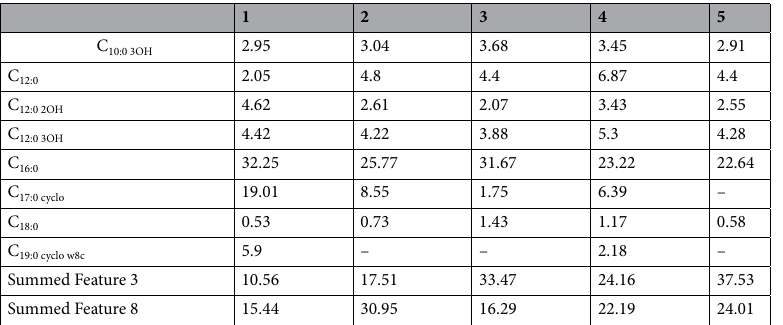
Table 4. Cellular fatty acid composition of Pseudomonas eucalypticola sp. nov. and the closely related species in Pseudomonas genus. Species/strain: 1, P. eucalypticola NP-1 T ; 2, P. coleopterorum LMG28558 T ; 3, P. graminis DSM11363 T ; 4, P. lutea LMG21974 T ; and 5, P. rhizosphaerae LMG21640 T . Only results with amounts higher than 0.5% for at least one strain are presented. Summed Feature 3 contained C16:1 w6c/C16:1 w7c; summed Feature 8 contained C18:1 w6c/C16:1 w7c.